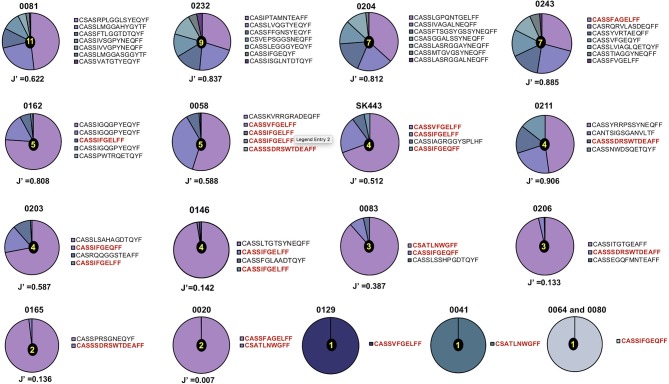
Distribution of TCR-β chain clonotypes in HLA-B*44:03/NW8-specific CD8+ T cells. The frequency distribution of TCR-β chain amino acid sequences obtained from (n = 18) CMV-infected individuals is shown as pie charts. Frequencies of individual clonotypes are calculated as a percentage of aligned sequencing reads. Amino acid sequences of CDR3 loops are shown on the right of each pie, with public CDR3 clonotypes in bold red. Patient IDs are shown above each pie chart. Shannon's evenness index (J′) is shown under each pie chart. The number in the centre of each pie indicates the total number of clonotypes seen in the corresponding patient. Colours are assigned randomly and do not correspond to a fixed a sequence.